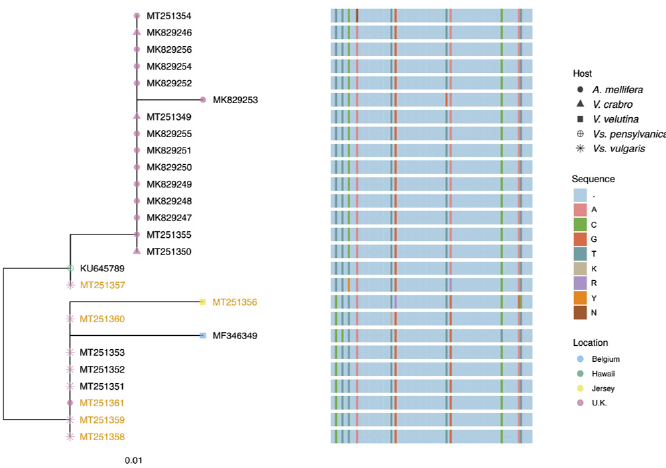
Figure 2. Phylogenetic tree and multiple sequence alignment of Moku virus sequences based on a region of the RdRp (8801 to 8894 nt on MV KU645789.1). Branch tip-points are colored by the location, and shaped by host. Tip labels that are colored yellow are derived from the negative sense assay. A multiple sequence alignment is shown next to corresponding sequences. Skyblue represent identical nucleotide sequences compared to the consensus, and the colored bars represent base pair substitutions.